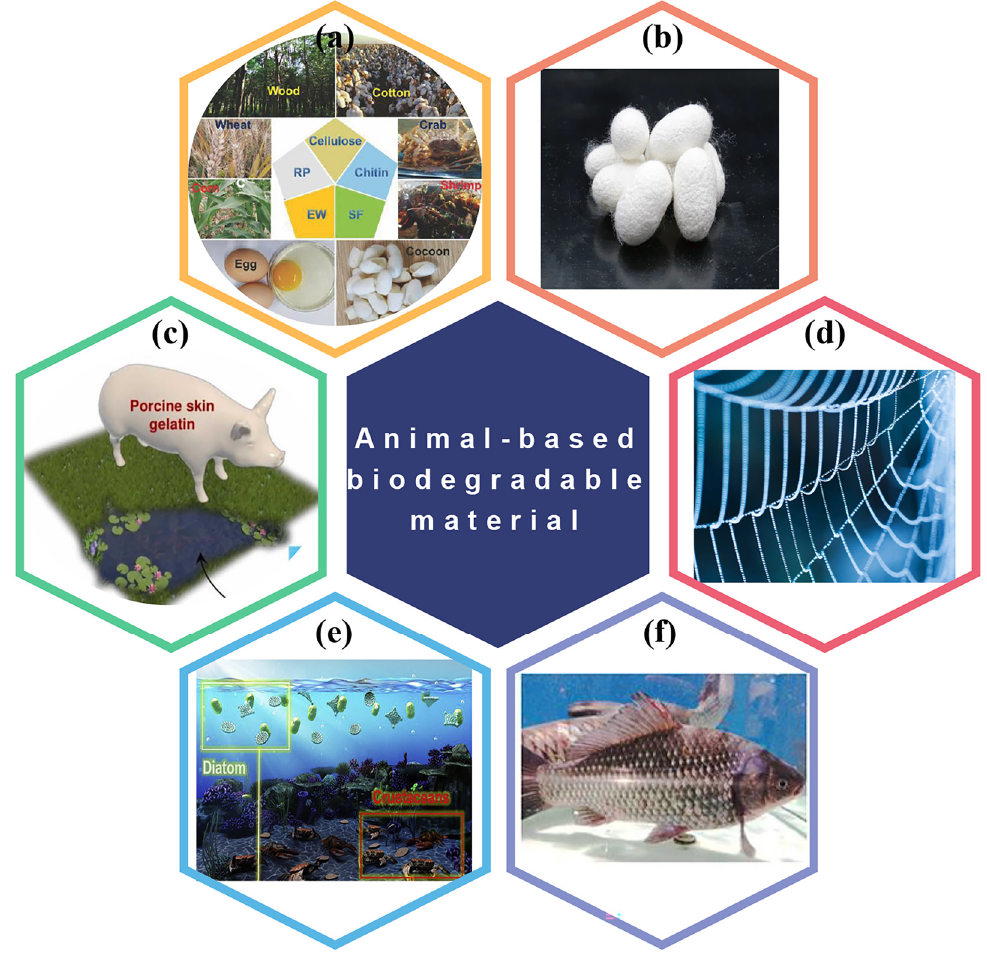
Figure 8. Animal based biodegradable polymers used in TENGs. ( a , b ) Natural BDPs originating from nature with wide raw material sources, including silk fibroin, egg, and chitosan. Reproduced